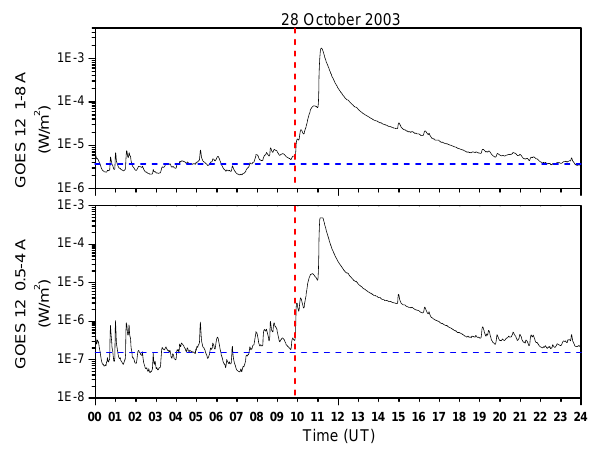
Fig. 6. Shows X-ray flux (1–8A and 0.5–4A) observed on 4 November 2001 by the satellite GEOS 12 from 12:00 UT to 24:00 UT. The blue horizontal line indicates the quiescent X-ray flux. The red vertical lines indicate the peaks in solar flare X-ray